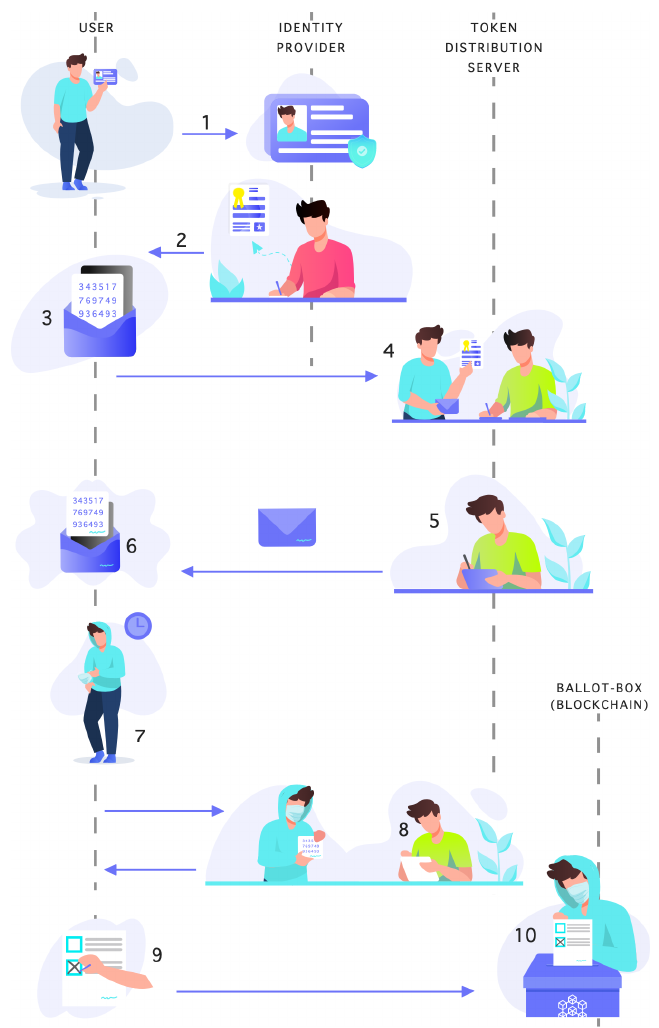
Figure 3. Sequence diagram of final